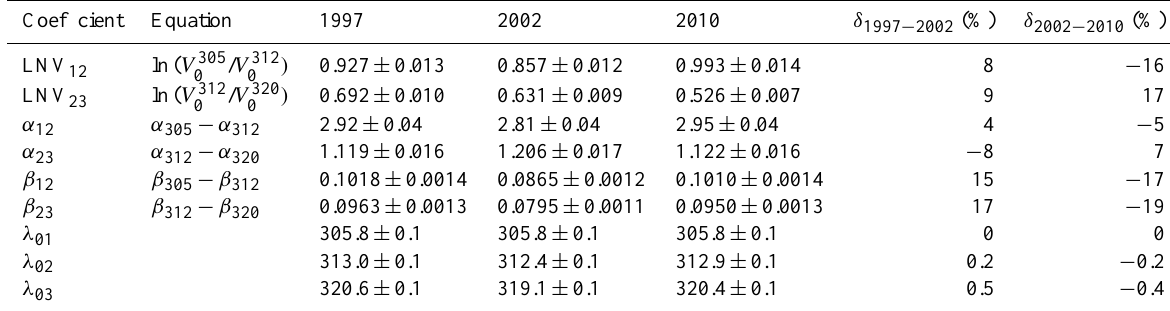
Table 1. Microtops (#3682) calibration coefficients determined in 1997, 2002, and 2010. Coefficient Equation